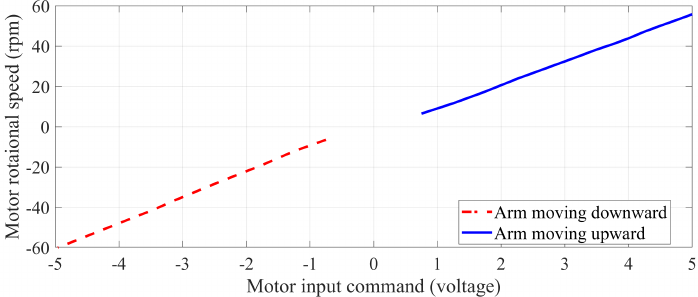
Figure 10. Relationship between motor controller input command and motor